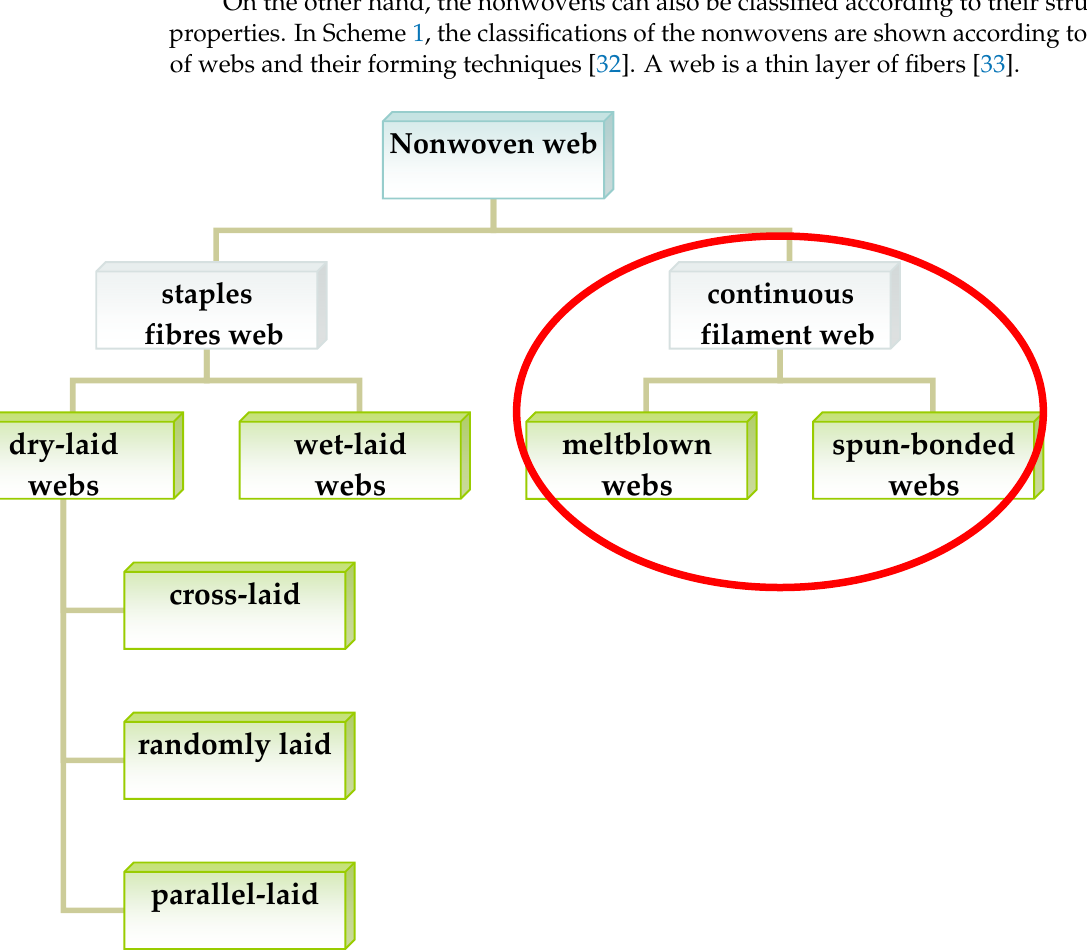
Scheme 1. Classification of nonwoven according types of